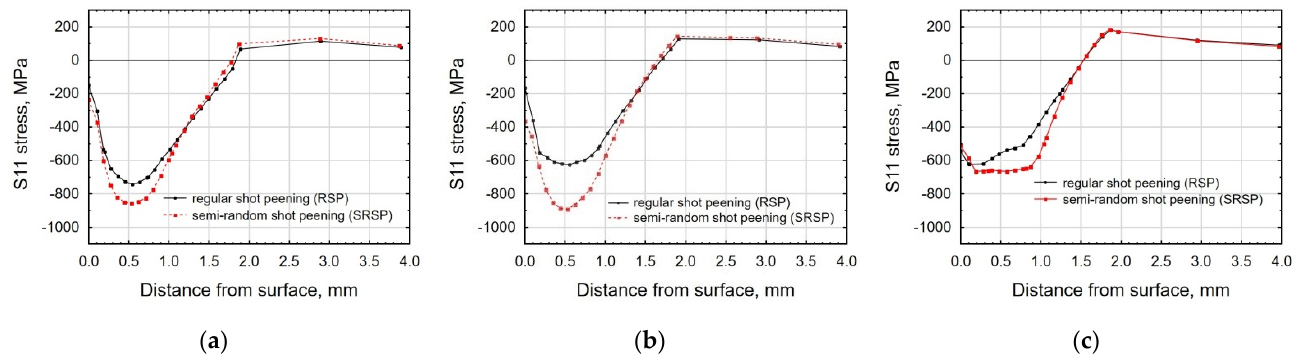
Figure 17. Comparison of the S11 stress distribution for RSP and SRSP as a function of distance from the surface for different distances between the dimples: ( a ) x = 0.15 mm, ( b ) x = 0.3 mm, ( c ) x = 0.6 mm.